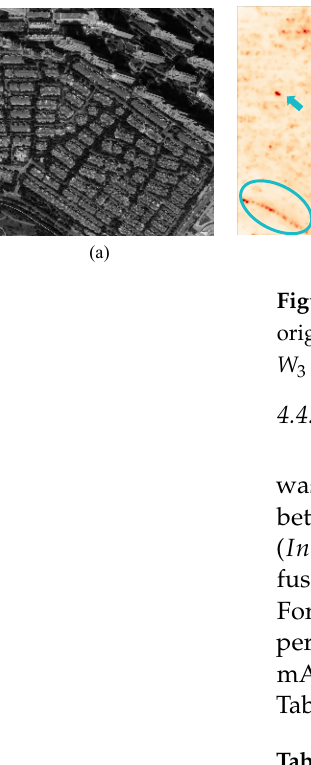
Table 2. Ablation test results in cross-modal